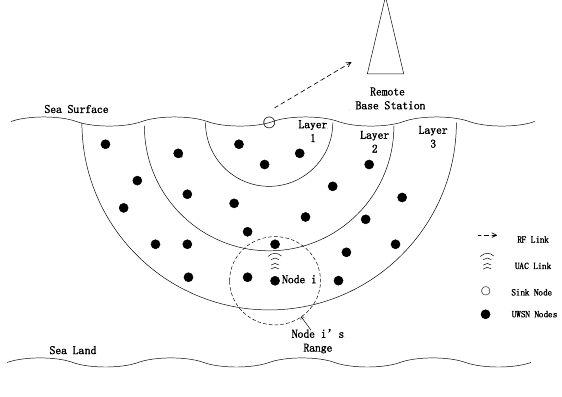
Figure 1. The Network